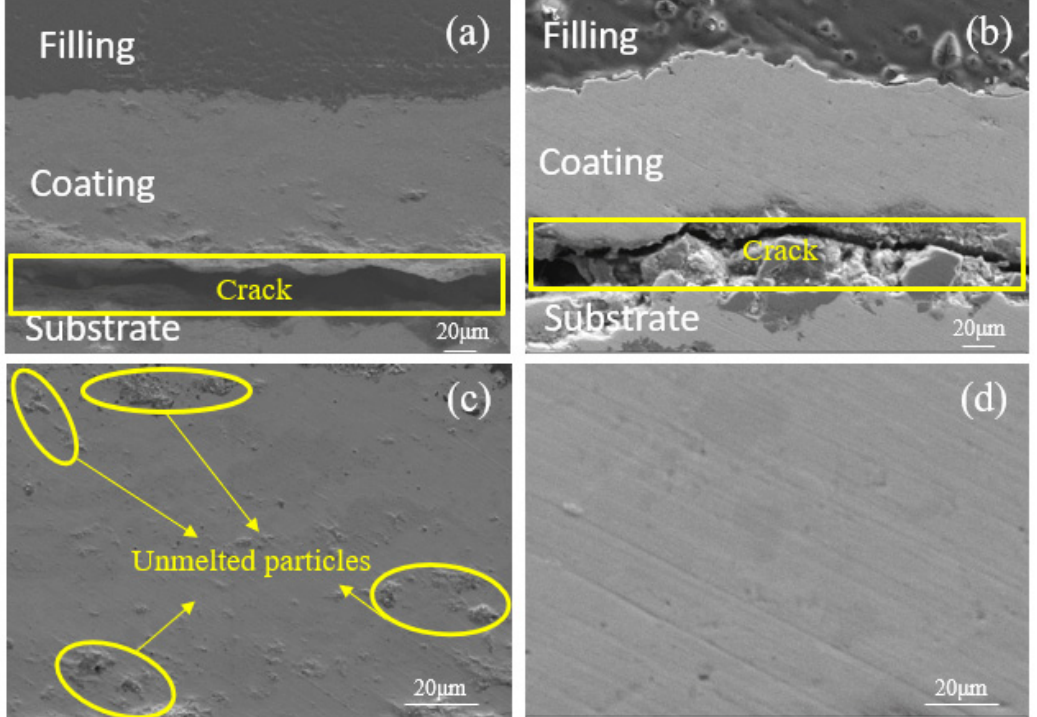
Figure 4. Cross-sectional images of the ( a ) KNN coating, ( b ) KNLN coating. and cross-section enlarged view of the ( c ) KNN coating, ( d ) KNLN coating.